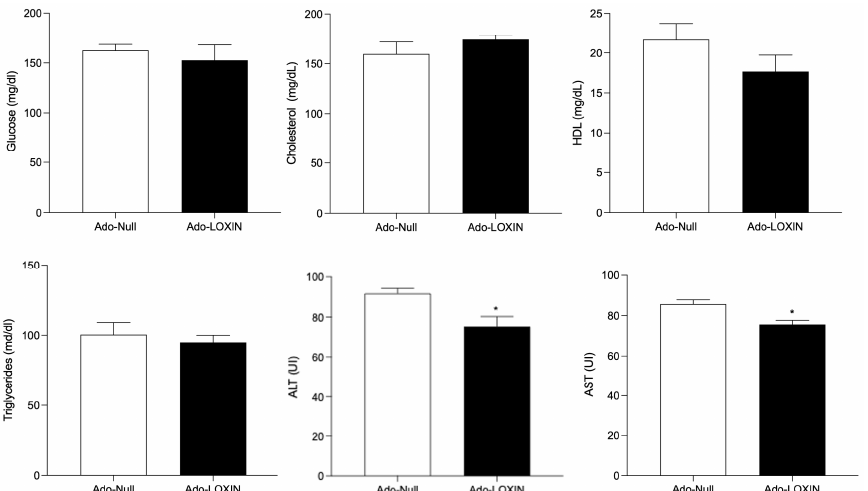
Figure 2. Metabolic characterization of mice fed a high-fat diet. Blood glucose, cholesterol, Triglyc- eride, HDL AST, and ALT were measured in mice fed a normal diet (ND) and high-fat diet (HFD) mice. Mice were infected with an adenovirus vector (1 × 10 8 Plaque-forming unit, pfu) expressing LOXIN (Ado-LOXIN) or empty vector (Ado-Null) via the tail vein. One-way ANOVA followed by a Tukey–Kramer test was used to examine the difference between the experimental group. Values are expressed as mean, and SEM n = 5. Statistical significance is represented as * p < 0.05. In terms of lipid deposition in aortic plaques and vessel intima disorganization, we observed a higher deposit of lipids in the aortas (Figure 3A) and more disorganization (Figure 3B) in tissues from HFD animals than their respective counterpart in the ND group, confirming the metabolic-induced impairments by the HFD.